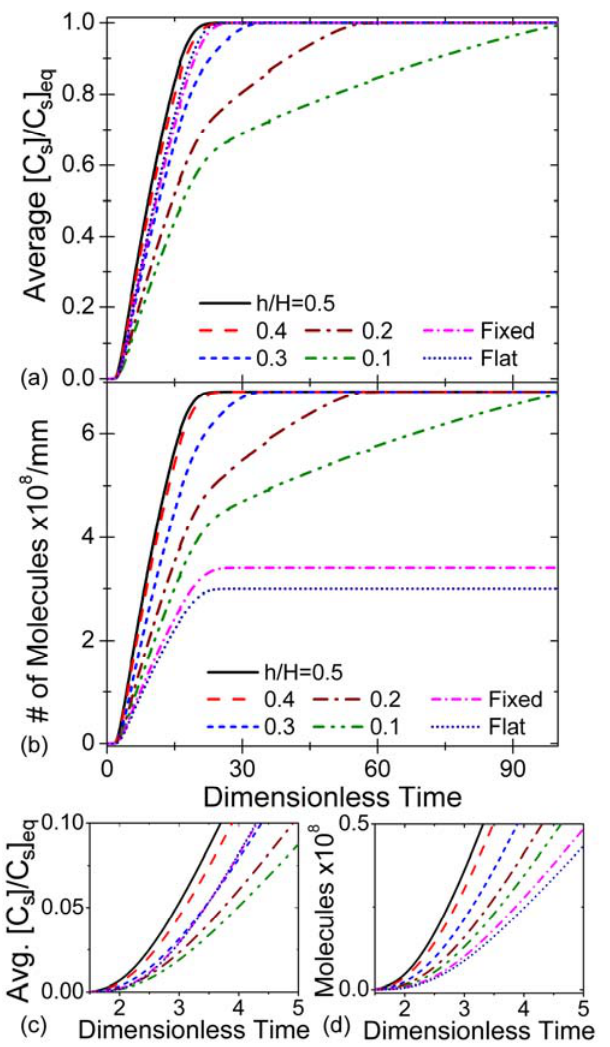
Figure 6. Binding curves for various sensor geometries (inlet bulk analyte concentration [A] = 100 nM, total surface concentration of binding sites [B] 0 average inlet flow velocity (cid:1874) = 5 × 10 − 5 m/s). All times are normalized with respect to τ (cid:3036)(cid:3041)